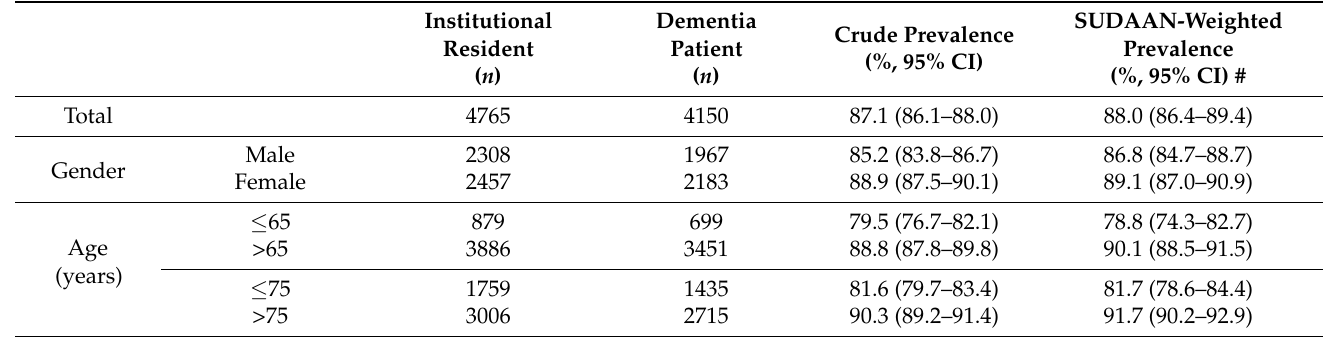
Table 2. Institutional dementia prevalence: crude prevalence and SUDAAN-weighted prevalence.